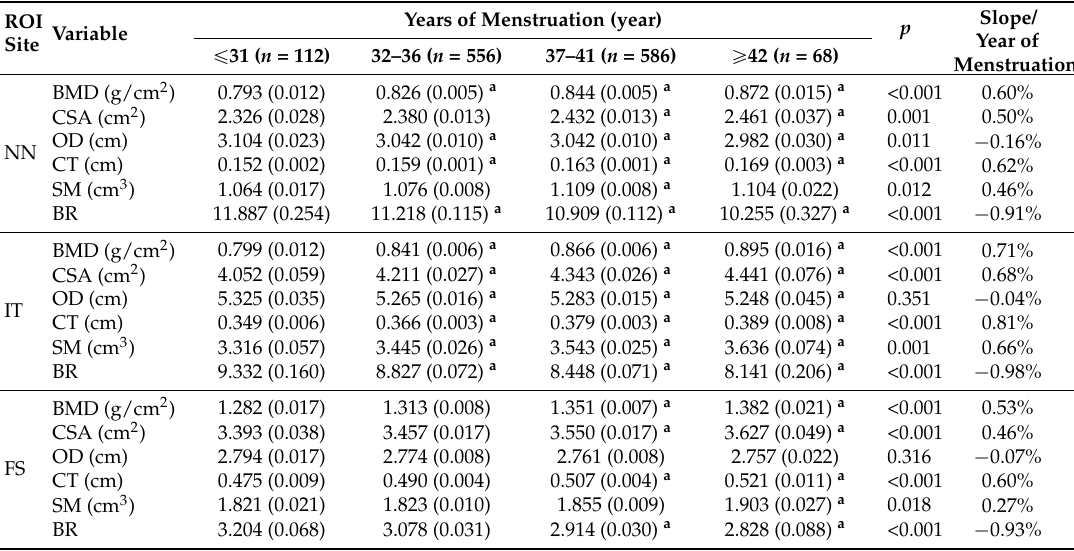
Table 5. BMD and HSA indices of subjects in different years of menstruation